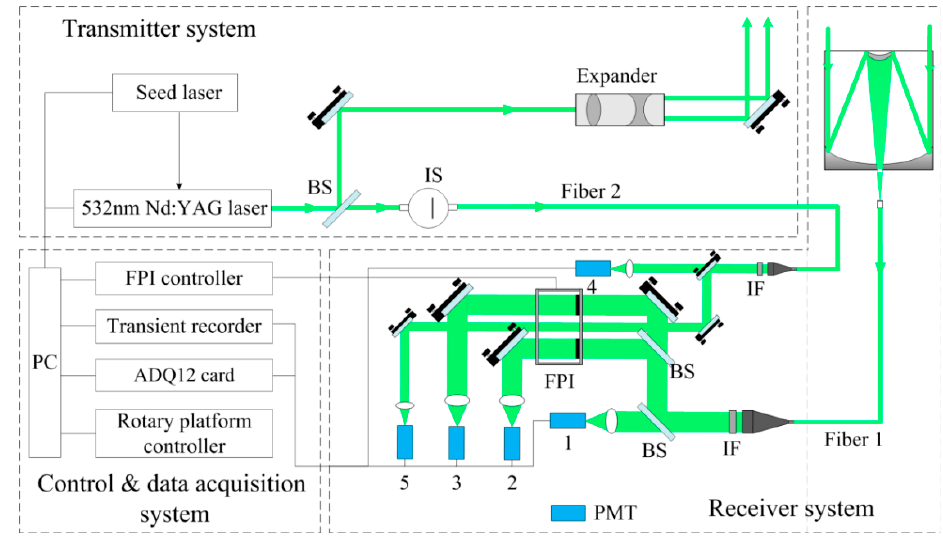
Figure 3. Schematic view of the Doppler lidar. BS, beam splitter; IS, integrating sphere; IF, interfer- ence filter. Table 1. Lidar system parameters.